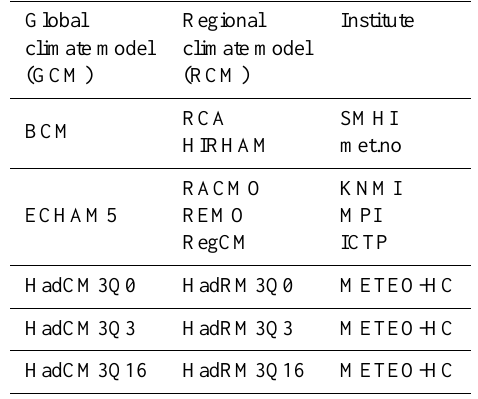
Table 2. The GCM/RCM combinations from ENSEMBLES used for the hydrological projections. The full names of the institute